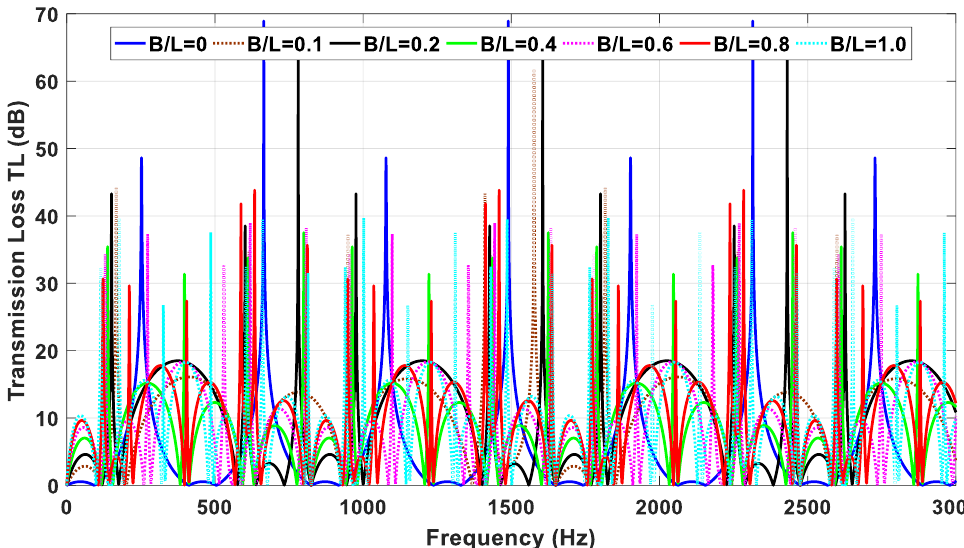
Figure 13. The TL of DCLCM with different S/C ratio (B/L).